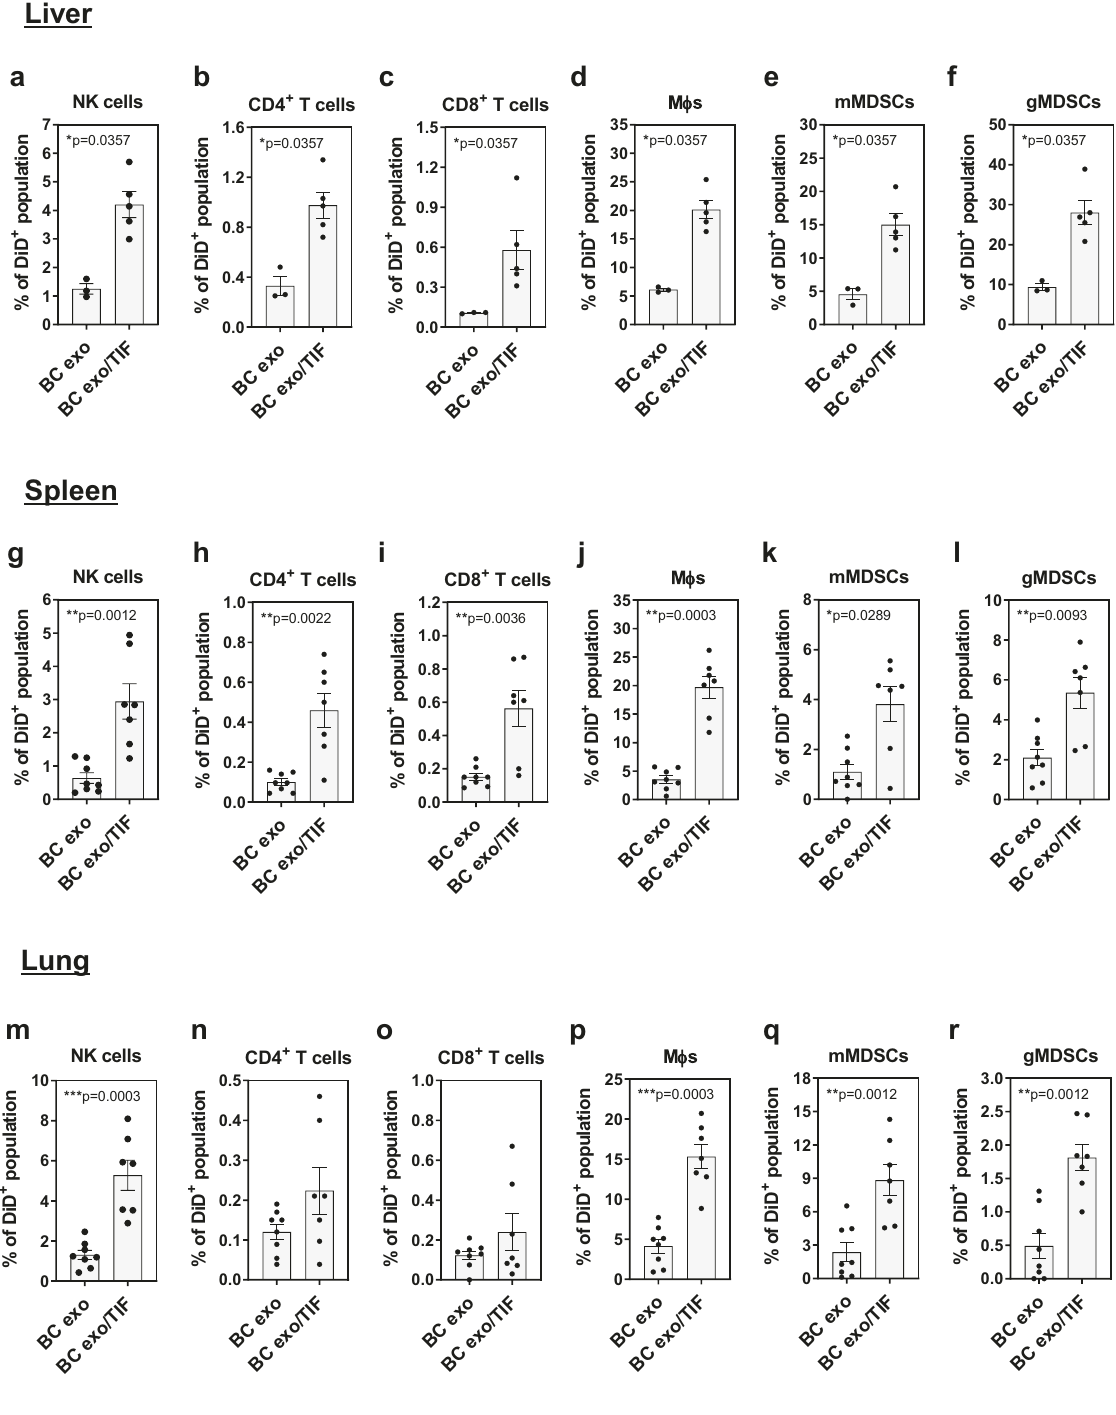
Fig. 2 Increased uptake of TIF-conjugated exosomes by immune cell subsets in the liver (a-f), spleen (g-l) and lung (m-r). C57Bl/6 WT mice were injected with DiD-labeled cell culture-derived EO771 exosomes previously incubated (BC exo/TIF, n = 7 animals) or not (BC exo, n = 8 animals) with TIF. a – r Frequency of DiD + population was assessed within distinct CD45 + immune cell subsets using fl ow cytometry: ( a , g , m ) NK cells (CD3 − NK1.1 + ); ( b , h , n ) CD4 + T cells (CD3 + CD4 + ); ( c , i , o ) CD8 + T cells (CD3 + CD8 + ); ( d , j , p ) macrophages (M ɸ ; CD11b + F4/80 + ); ( e , k , q ) mMDSCs (CD11b + Gr1 lo ); and ( f , l , r ) gMDSCs (CD11b + /Gr1 hi ). Data are presented as mean ± SEM. * p < 0.05, ** p < 0.01, and *** p < 0.001 as analyzed by two-tailed Mann – Whitney U